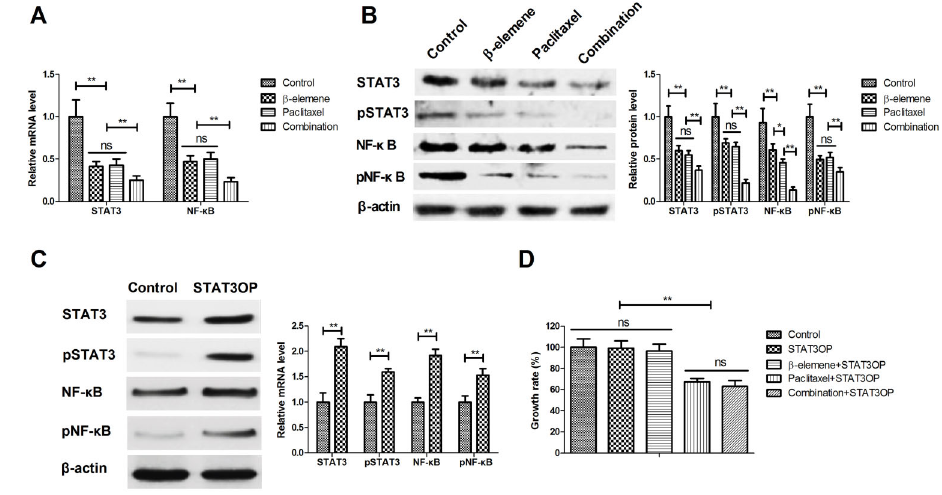
Figure 5. Effect of b -elemene + paclitaxel on relative STAT3 and NF- k B mRNA ( A ) and protein ( B ) expression levels in SKOV3 cells. C , Effects of STAT3 overexpression (STAT3OP) and NF- k B expression and phosphorylation in SKOV3 cells. D , Effects of STAT3